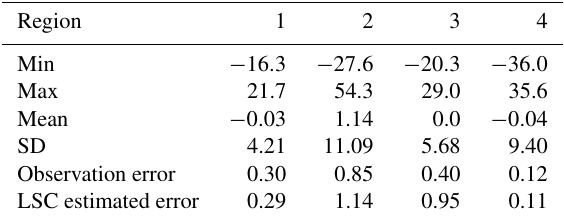
Table 10. Accuracy of the LSC gravity estimation based on the im- proved local COV modeling in each region (mGal).